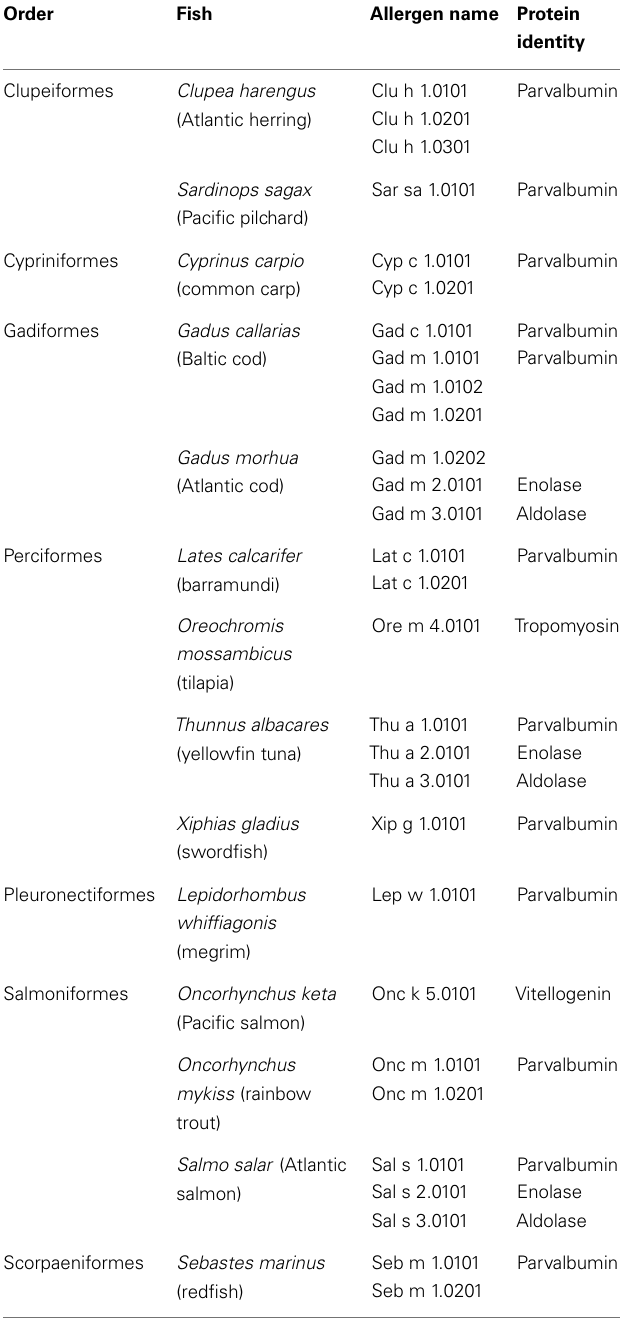
Table 1 | Entries of official fish allergens by the International Union